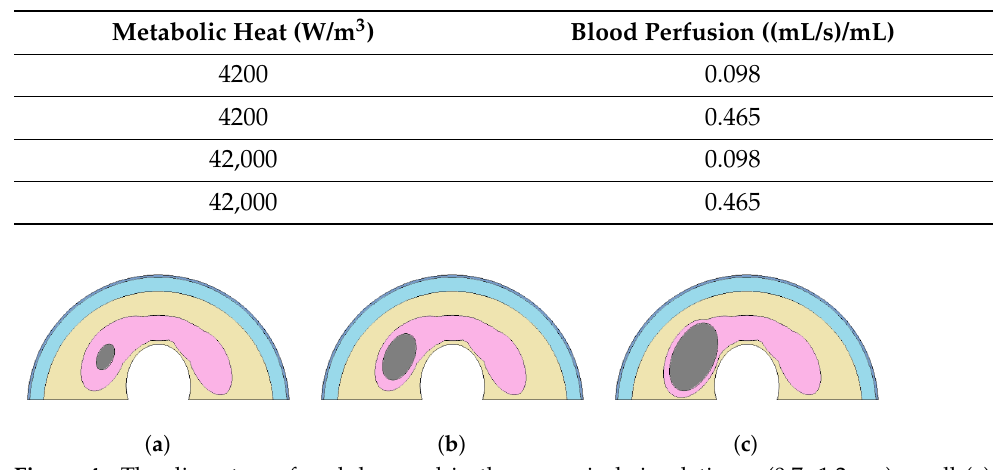
Figure 4. The diameters of nodules used in the numerical simulations: (0.7; 1.2 cm) small ( a ), (2.2; 1.26 cm) medium ( b ), and (3.14; 1.80 cm) large ( c